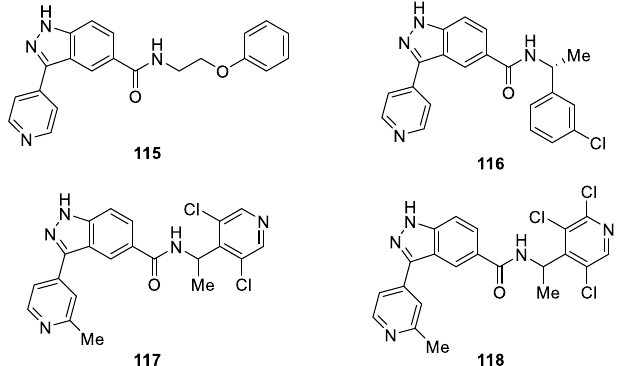
Figure 25. Chemical structures of 1 H -indazole amide derivatives 115 – 118.